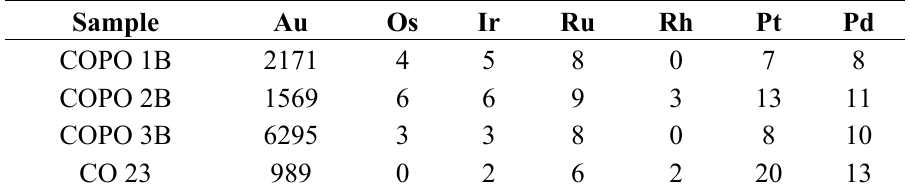
Table 2. Concentration of Au and platinum group elements (PGE) (ppb) in the deposits of Corchia. Sample